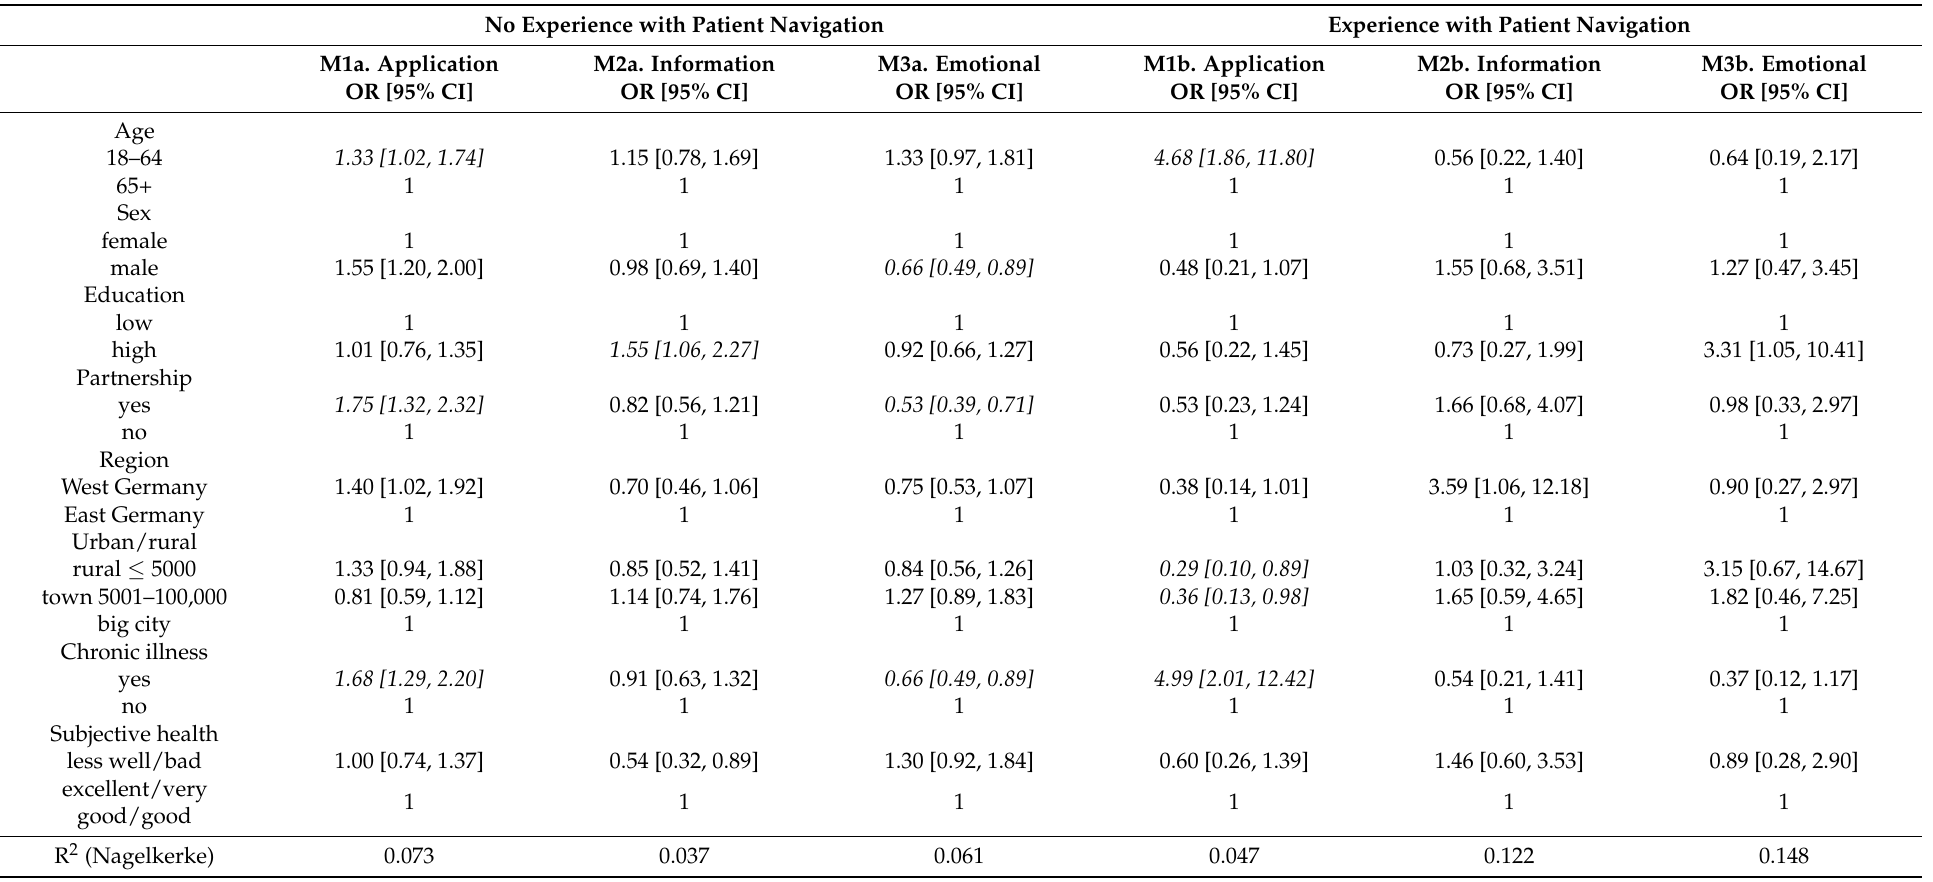
Table 2. Associations between the most important tasks within both groups and sociodemographic characteristics (multiple binary logistic regressions, OR 95%